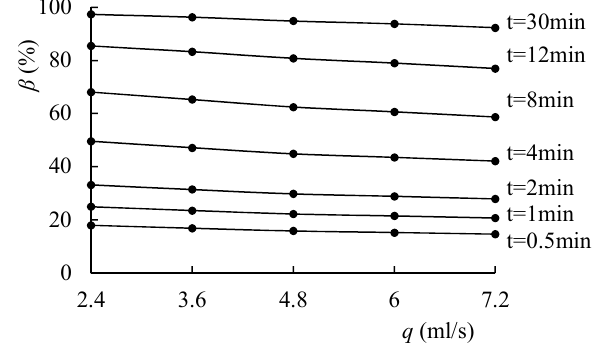
Figure 7. The ESR ( β )—recharge intensity ( q ) relationship curves.